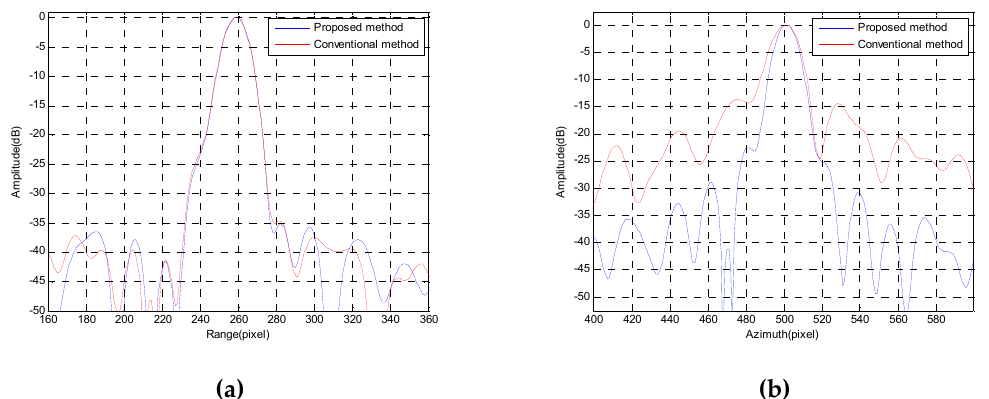
Figure 11. Comparison of the point target profile (M = 16): ( a ) Range profile; ( b ) Azimuth profile.